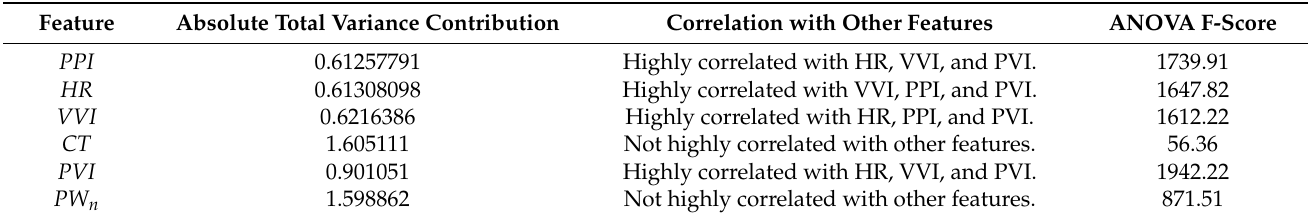
Table 2. The Analysis of Commonly Used Features Set.